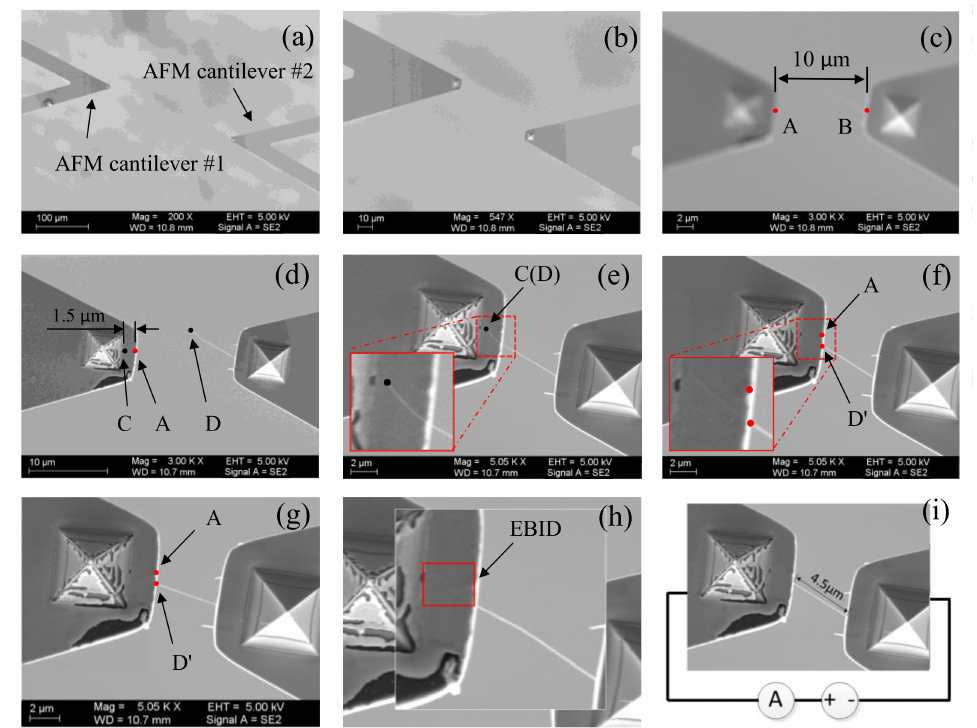
Figure 12. The procedure of automated measurement of individual CNTs by visual recognition. ( a ) Moving the two AFM cantilevers toward he FOV center for their initial positions; ( b , c )